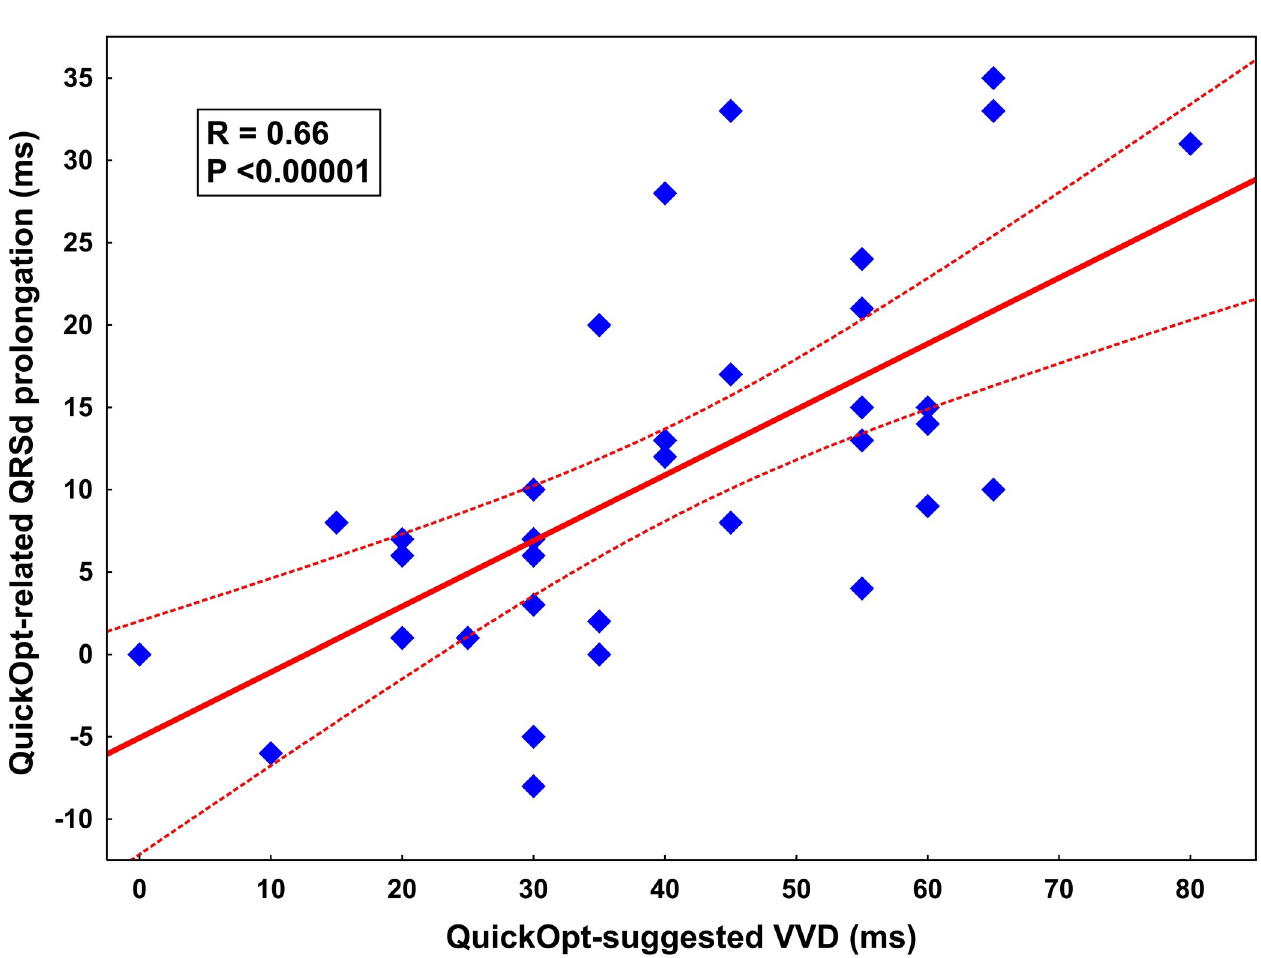
Fig 4. Correlation between QuickOpt-suggested VVD and QuickOpt-related QRSd prolongation. QRSd, QRS duration; VVD, ventriculo-ventricular delay.